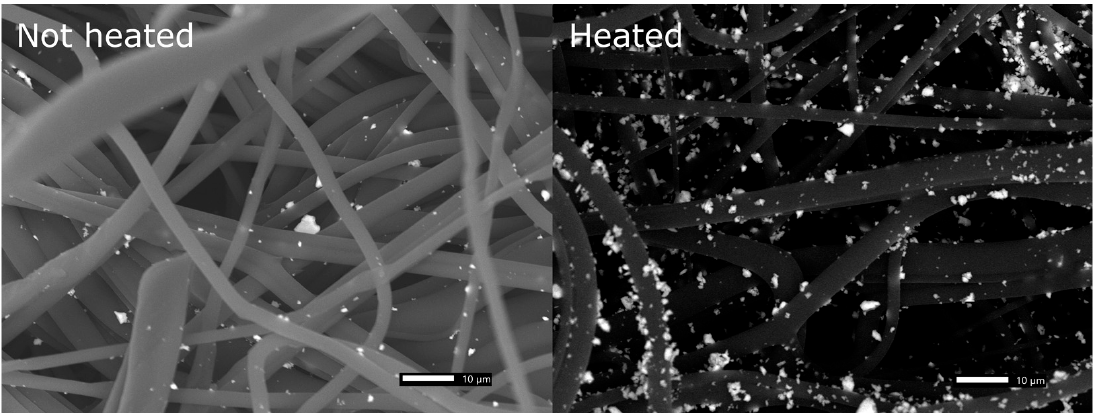
Figure 2. Scanning electron microscopy (SEM) images of polypropylene fabric treated with Cu 2 O particles. Left: with no heat treatment after particle attachment. Right: with heat treatment after particle attachment. Both samples were washed with ethanol, but the heat-treated sample retained a greater density of Cu 2 O particles.